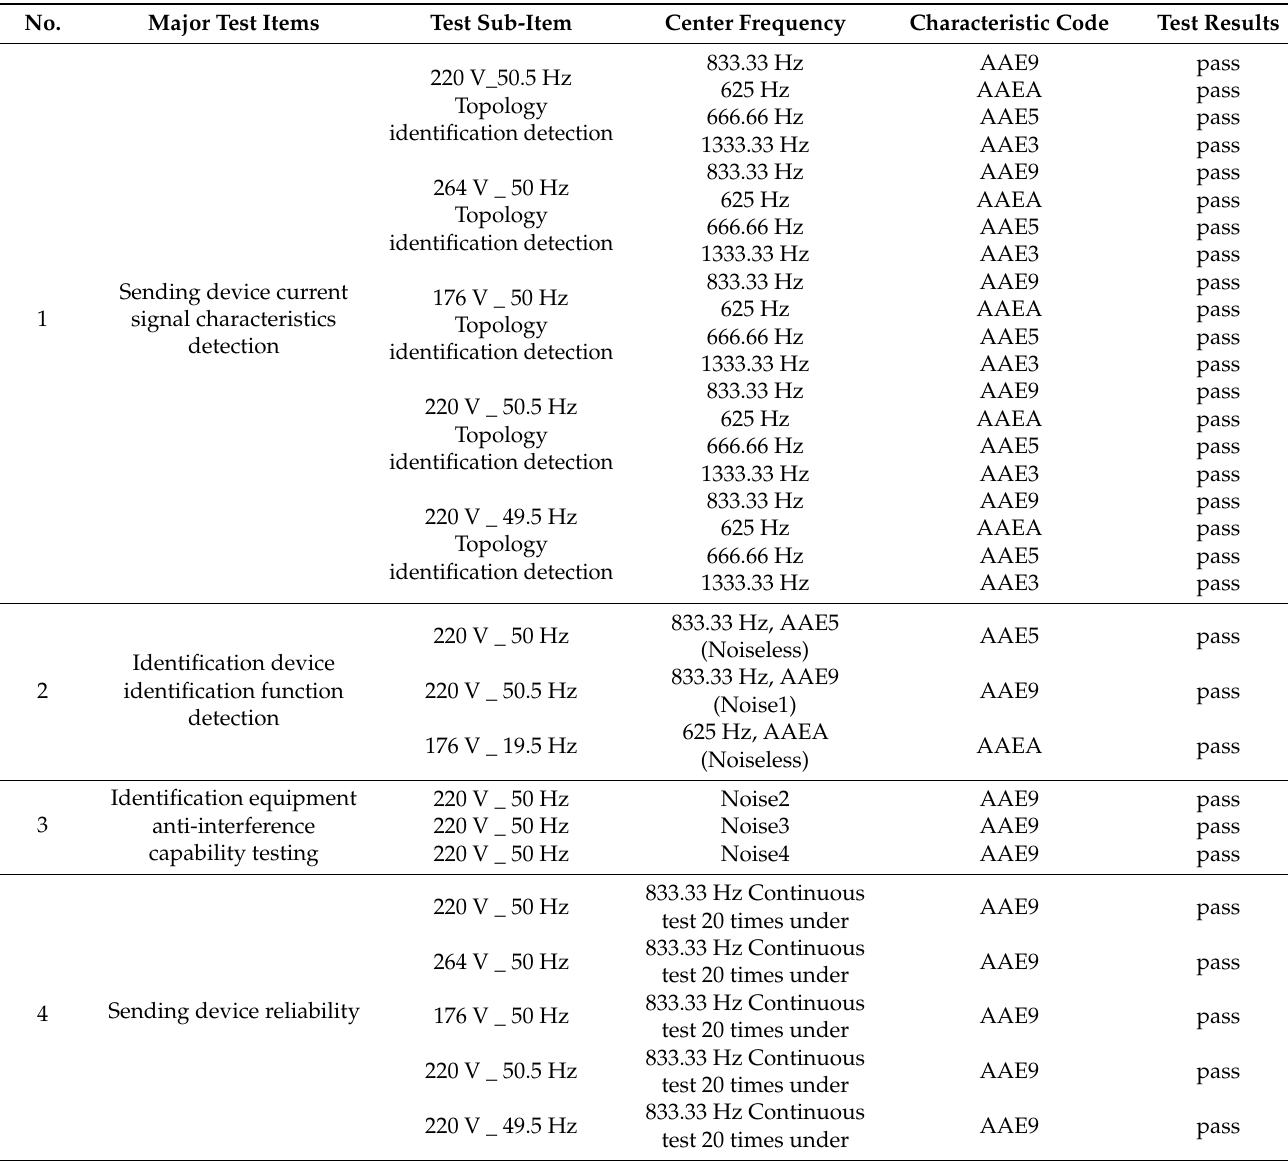
Table 5. Test results of intelligent measurement switches.